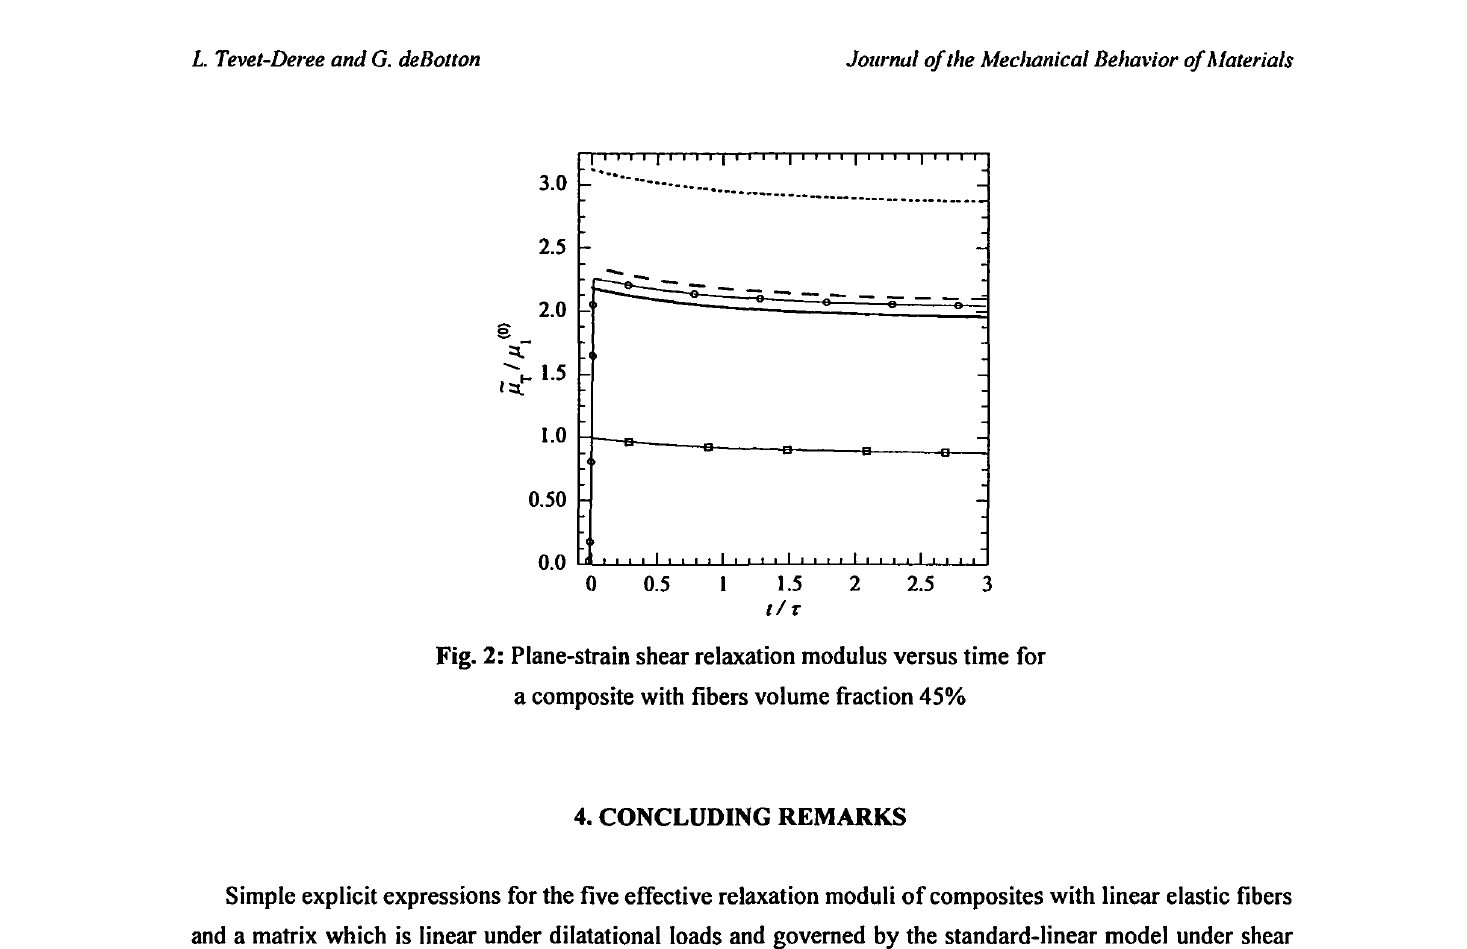
Fig. 2: Plane-strain shear relaxation modulus versus time for a composite with fibers volume fraction